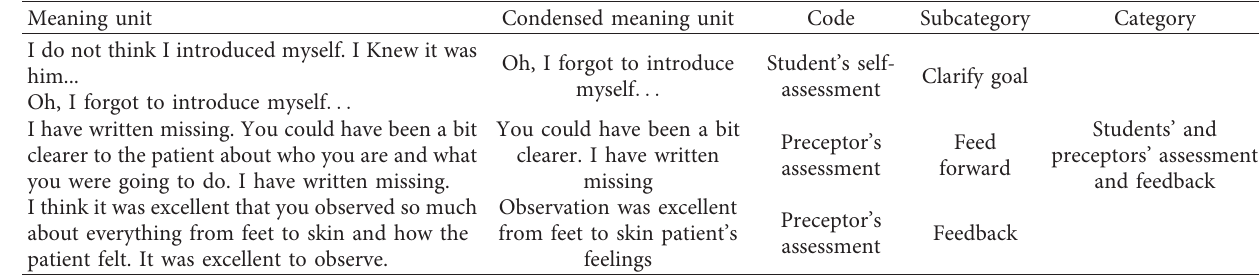
Table 2: Example of the analytical